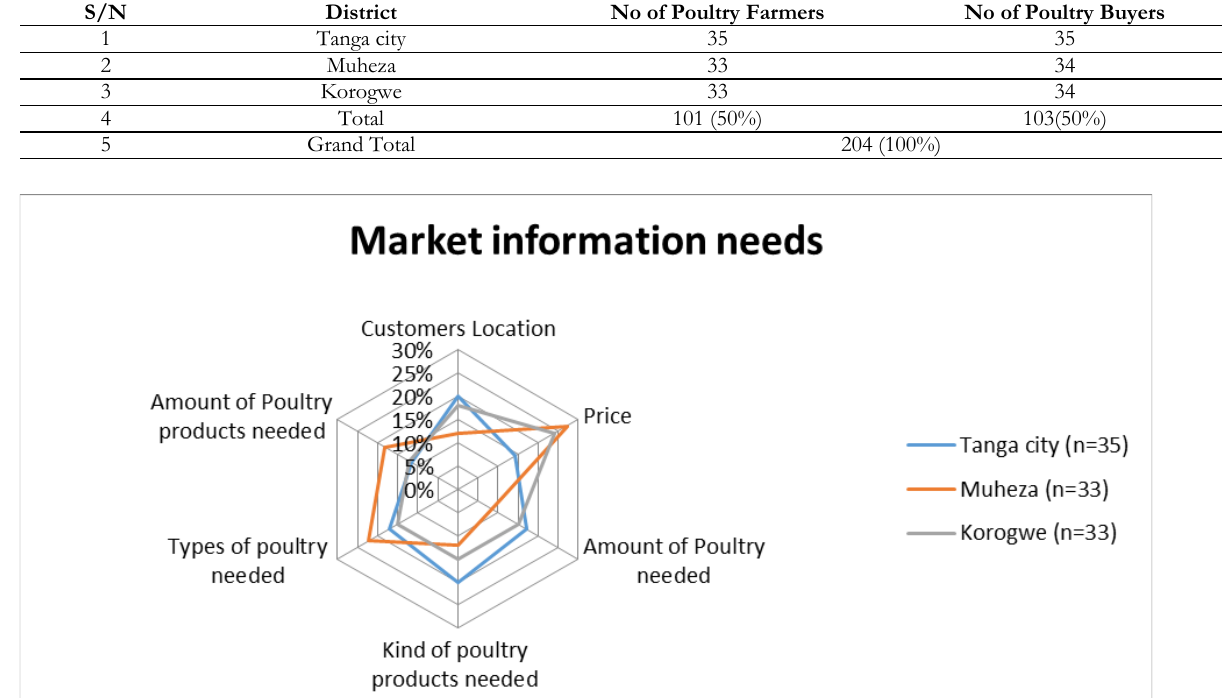
Table 1. Selected Poultry Farmers and Buyers Tanga Region